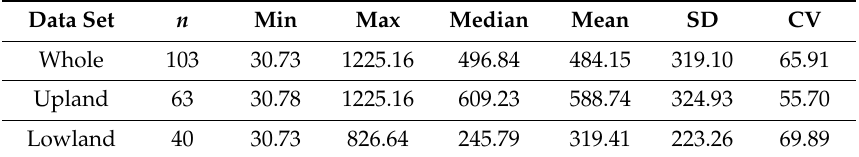
Table 2. Descriptive statistics of soil oxalate-extractable P data. n , number of samples; SD, standard deviation; CV, coefficient of variation (SD/mean × 100%).